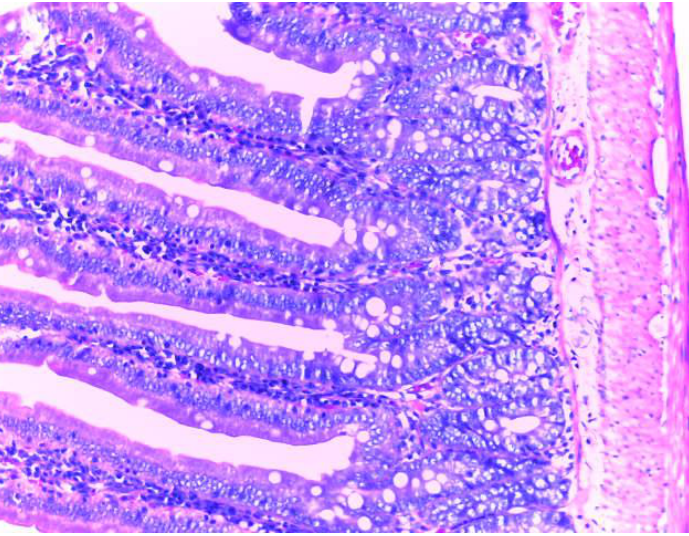
Figure 9. Normal histological appearance of the small intestine in group I (H&E stain, ob 20X).